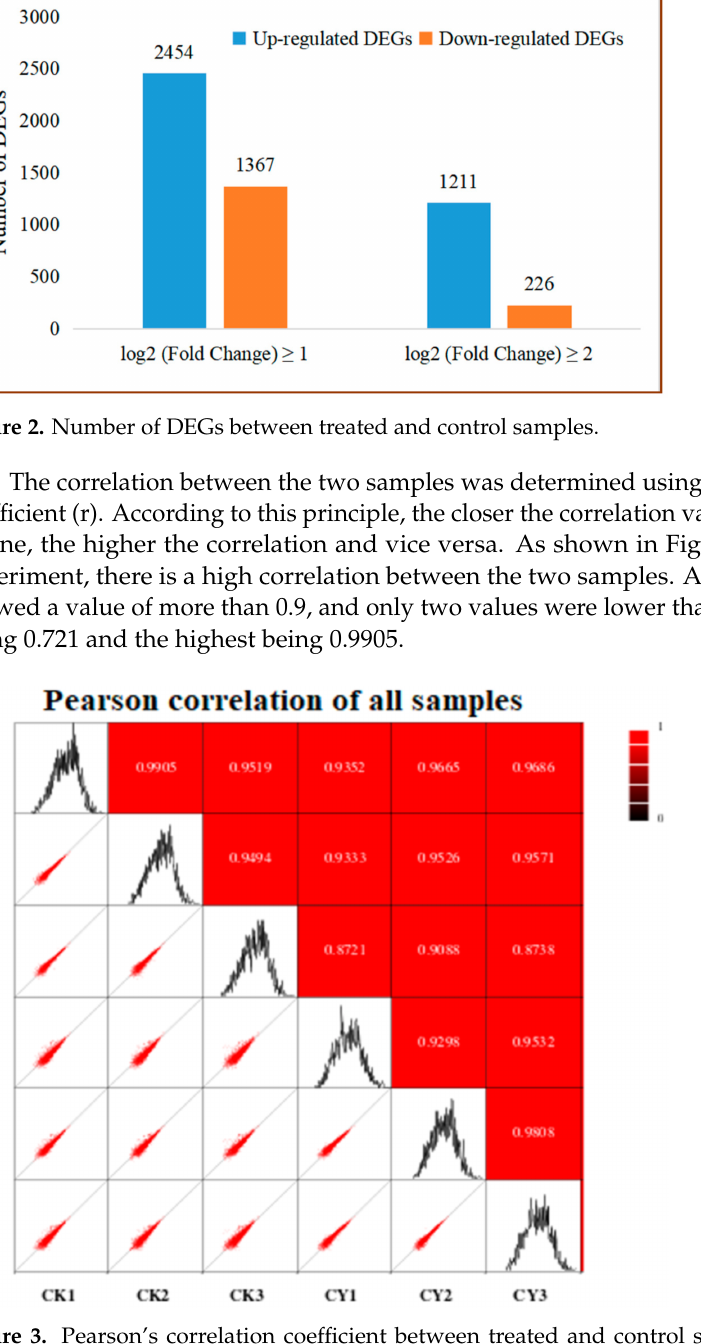
Figure 3. Pearson’s correlation coefficient between treated and control samples; the higher the correlation between the two samples, the closer the value is to 1. CK = control and CY = P. anomala induced with chitosan (1% w / v